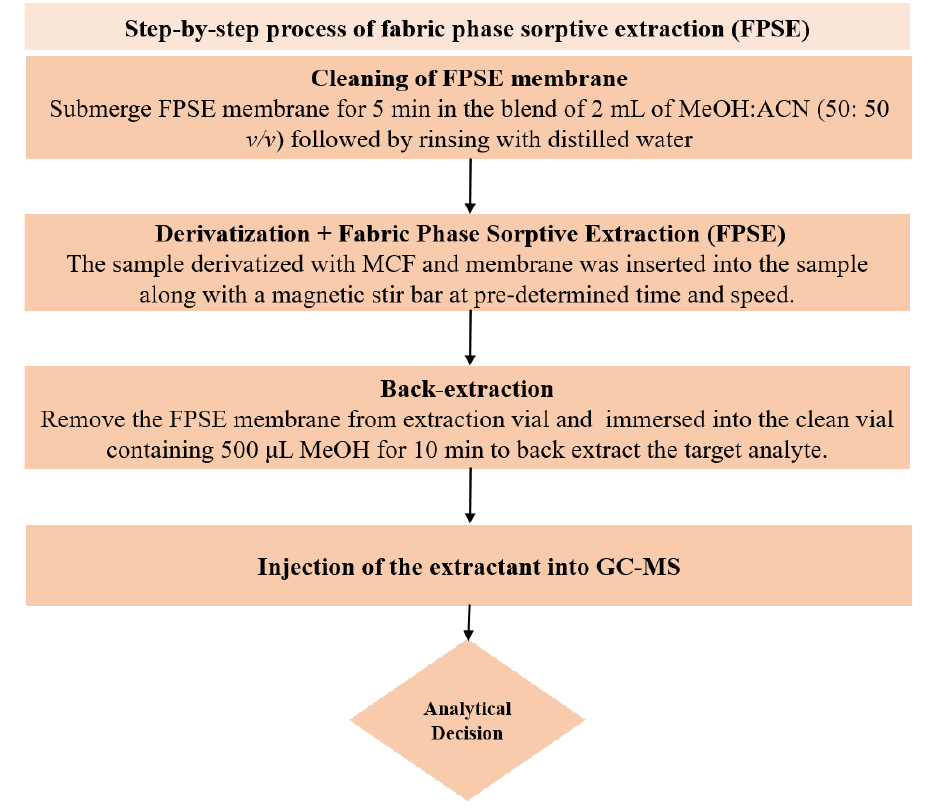
Figure 5. Schematic depiction of the steps included in FPSE